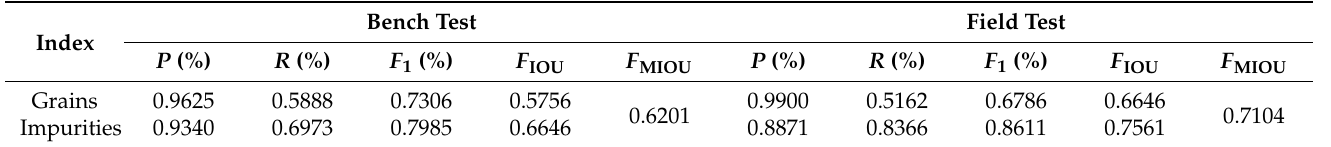
Table 2. Online recognition and segmentation performance of ResNet-50 model.